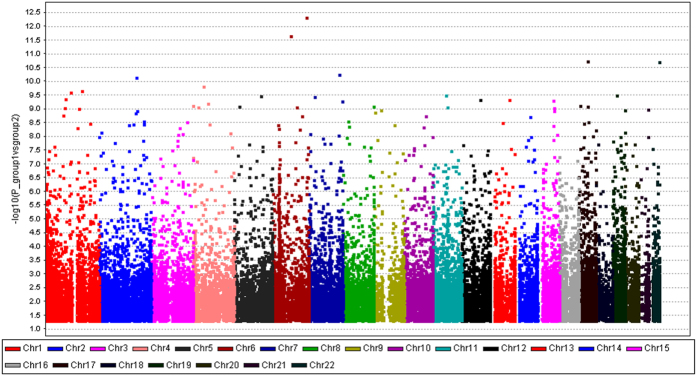
Manhattan scatter diagram illustrating the distribution of differentially methylated DNA sites in the human genome relative to individual chromosomes.The differentially methylated sites, including the 216 sites with P < 1.03e-07 by Bonferroni correction test, appear to distribute across all 22 chromosomes without apparent preference.